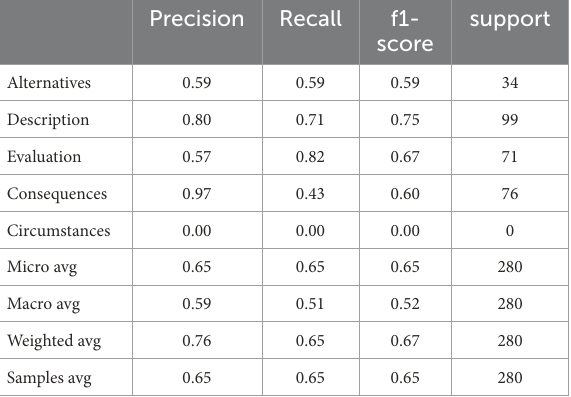
TABLE 2 Performance of ML-base on test dataset from non-physics preservice teachers. Precision